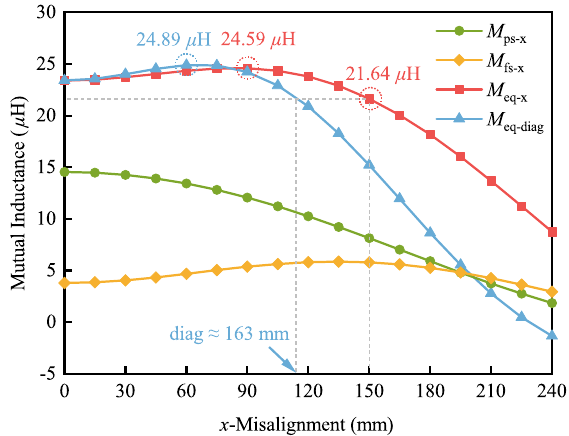
Figure 5. Variations of M ps − x , M sr − x , and the comparison between M eq − x and M eq − diag versus misalignment under x -misalignment from 0 to 240